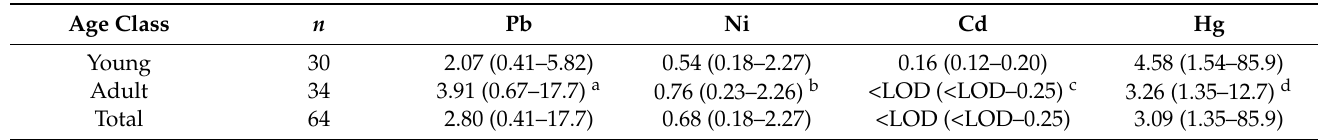
Table 1. Toxic heavy metal (THM) levels (mg/kg) in feathers of Eurasian magpies of different age-class. All data are expressed as median and range. LOD = limit of